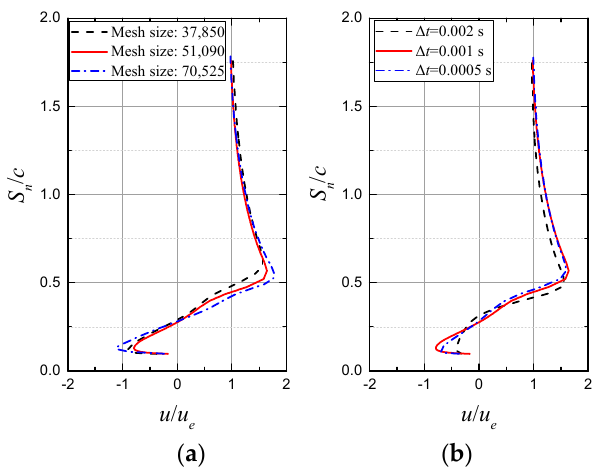
Figure 7. Effects of grid resolution and time steps on streamwise velocity profile at mid-chord at φ = 90°. S n is a normal distance away from the mid-chord, and u e is the streamwise velocity of external flow. ( a ) Effect of grid resolution; ( b ) Effect of time steps.